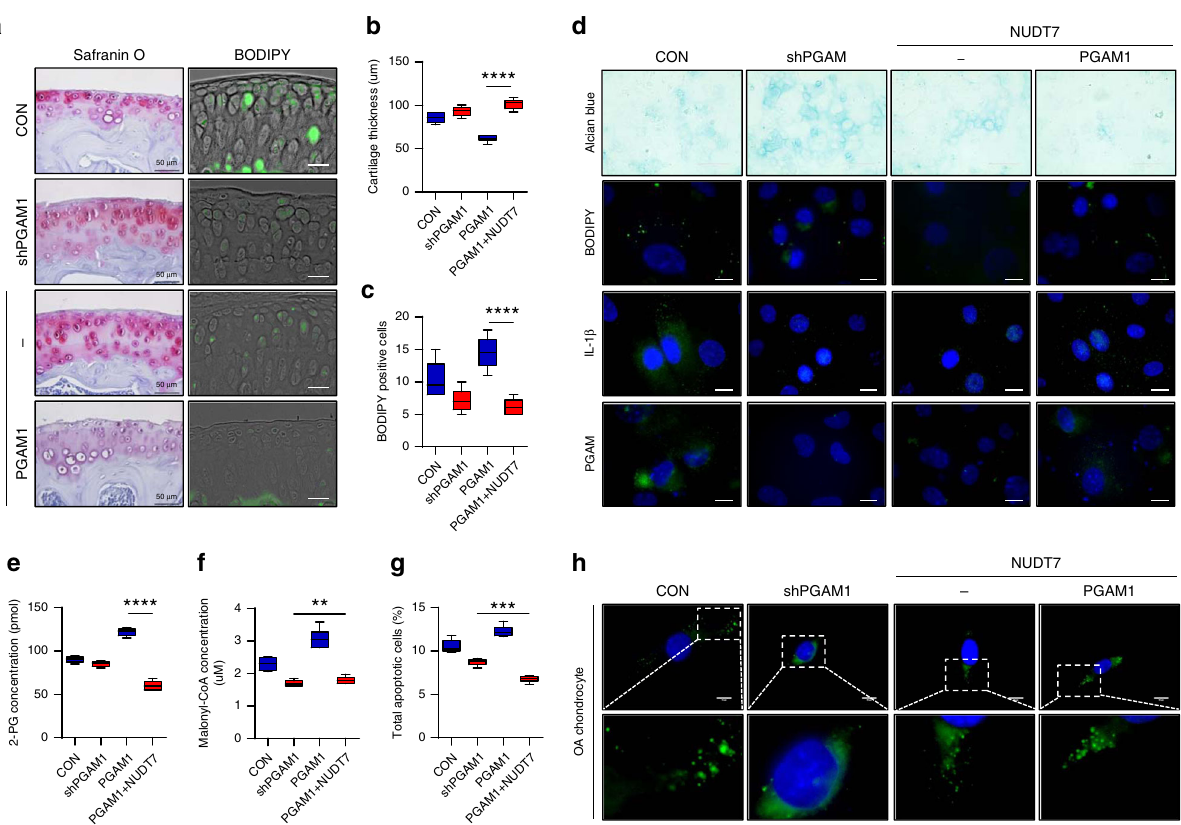
Fig. 6 Cartilage destruction by phosphoglycerate mutase 1 ( PGAM1 ) is reversed by co-introduction of NUDT7 . a Staining with safranin O and BODIPY 493/ 508 using the cartilage of Nudt7 − / − mice infected with lentivirus containing either PGAM1 shRNA ( shPGAM ) or NUDT7 into the joint cavity 10 weeks after destabilization of the medial meniscus (DMM) surgery ( n = 5, Scale bar, 50 μ m). b , c Analysis of cartilage thickness, BODIPY 493/508 -positive cells from staining with safranin O, and BODIPY 493/508 from Fig. 6a. d Staining of BODIPY 493/508 , IL-1 β , and PGAM1 with the introduction of shPGAM1 or NUDT7 and/or PGAM1 into iMACs of Nudt7 + / + mice ( n = 6 per group). Scale bars, 10 μ m. e – g Analysis of 2-phosphoglycerate, malonyl-CoA, and apoptotic cell death in immature murine articular chondrocytes (iMACs) of Nudt7 − / − mice infected with lentivirus containing shPGAM or NUDT7 and/or PGAM1 ( n = 6 per group). h BODIPY 493/508 staining of human osteoarthritis (OA) chondrocyte infected with lentivirus containing shPGAM or NUDT7 and/or PGAM1 ( n = 6 per group). Scale bars, 10 μ m. Values are means + s.d. An unpaired Student ’ s t test was used for statistical analysis. ** P < 0.01, *** P < 0.001, **** P